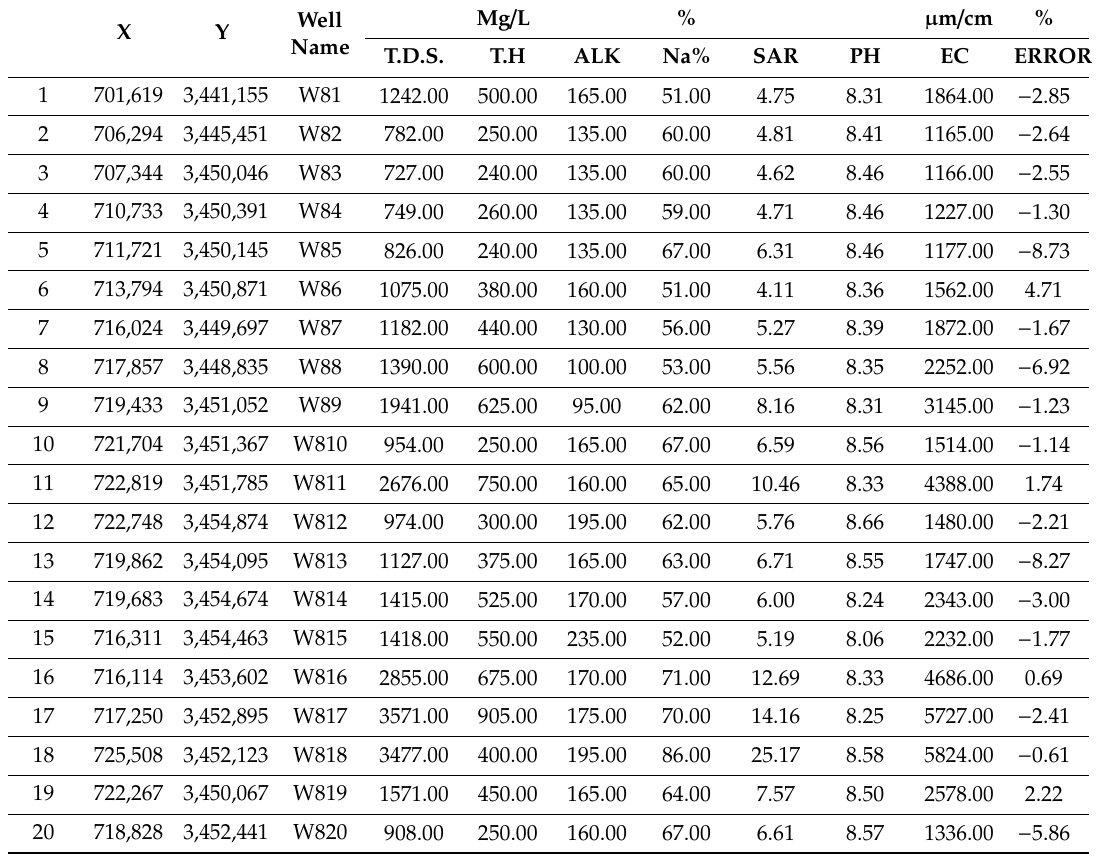
Table 2. Chemical analysis of selected wells in the Abarkooh